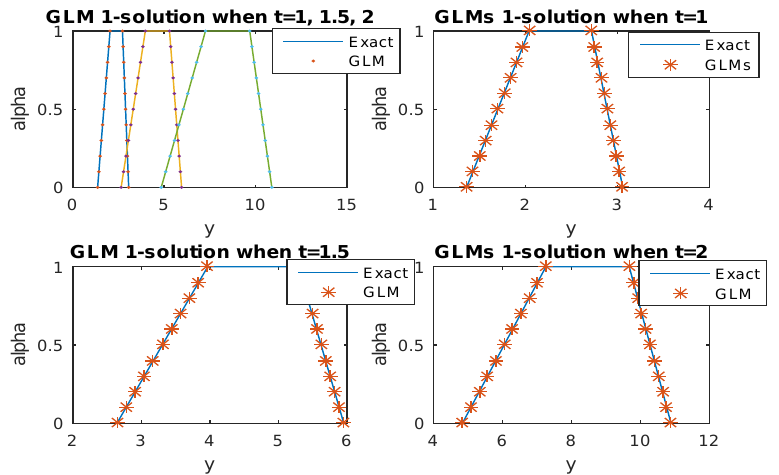
Figure 8. Exact(line) and GLM 1-solutions(stars) for Example 2 when t = 1.0, 1.5 and 2.0 with trapezoidal fuzzy numbers as the initial conditions.